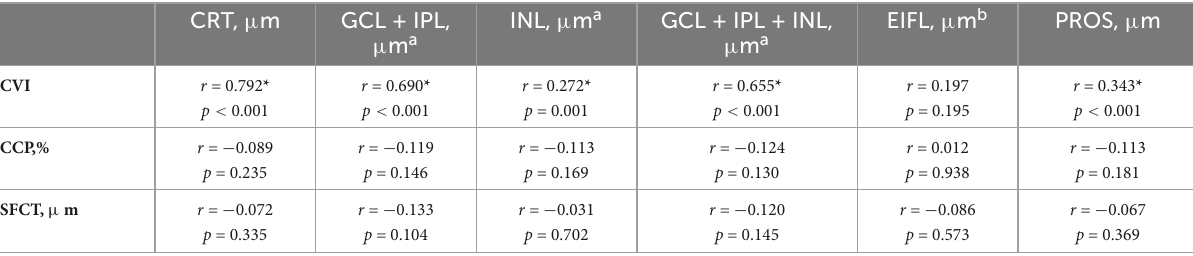
TABLE 2 The association between retinal and choroidal parameters in eyes with epiretinal membranes ( N = 181).